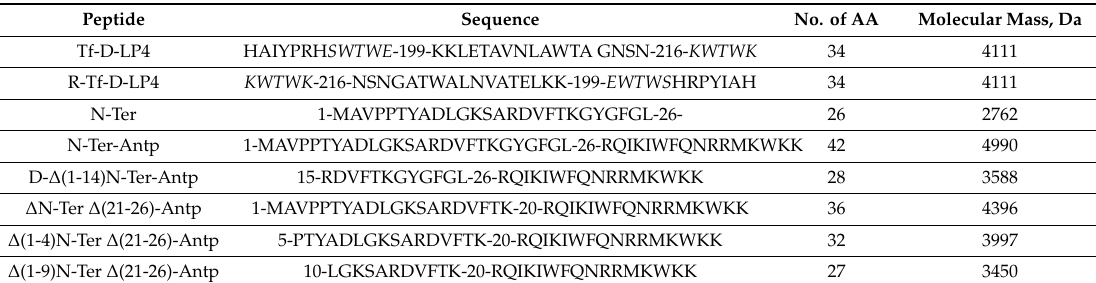
Table 4. Amino acid sequences and analytical data for the VDAC1-based